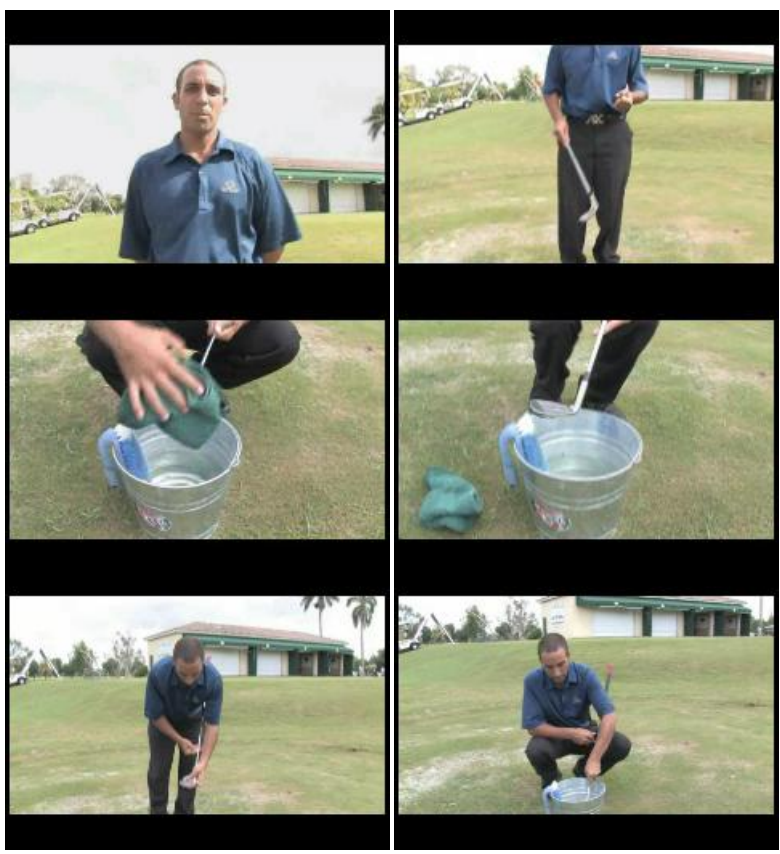
Figure 2. Examples of test images showing different